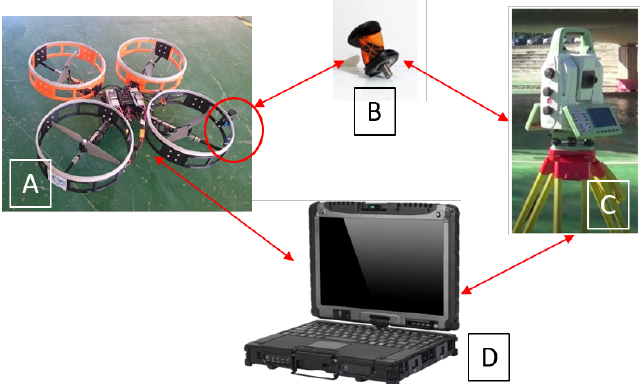
Figure 3. Robotics bridge-inspection system. ( A ) Aerial platform, ( B ) onboard reflector prism, ( C ) total station, and ( D ) ground-control system for monitoring and collecting flight and inspection